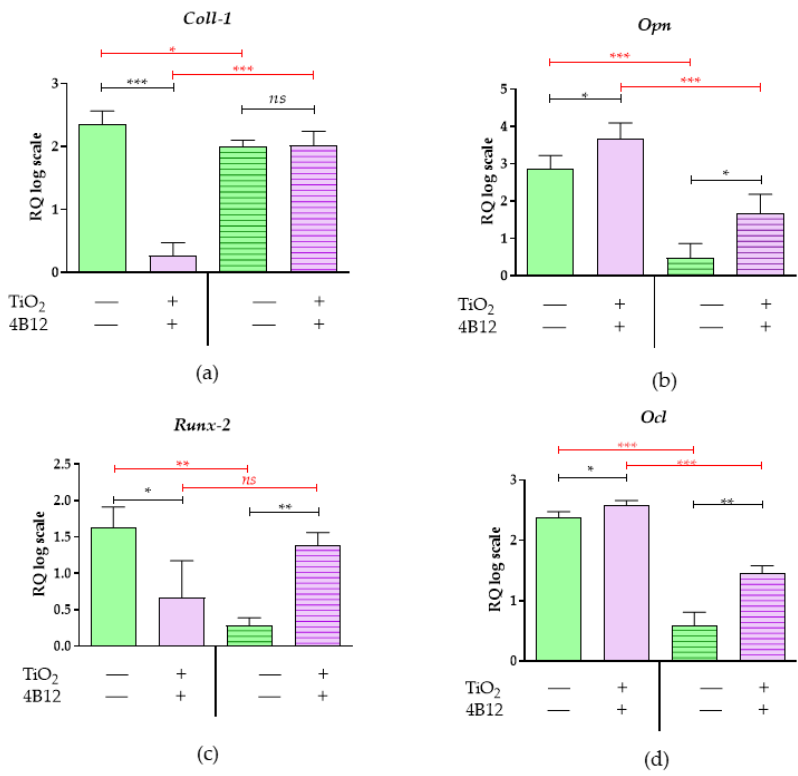
Figure 10. The mRNA expression of genes associated with osteogenic potential. The analysis of the control culture (TiO 2 ALD coatings -) and the culture propagated on TiO 2 coatings (TiO 2 ALD coatings +; experimental culture) examined ( a ) Coll-1, ( b ) Opn, ( c ) Runx-2, and ( d ) Ocl. The transcripts’ profiles were measured using the RT-qPCR technique. The relative quantification (RQ) was performed using the RQMAX method and the results are presented in a log scale. (significant differences are marked with asterisks (*** p < 0.001; ** p < 0.01; * p < 0.05), non-significant results are marked as ns).